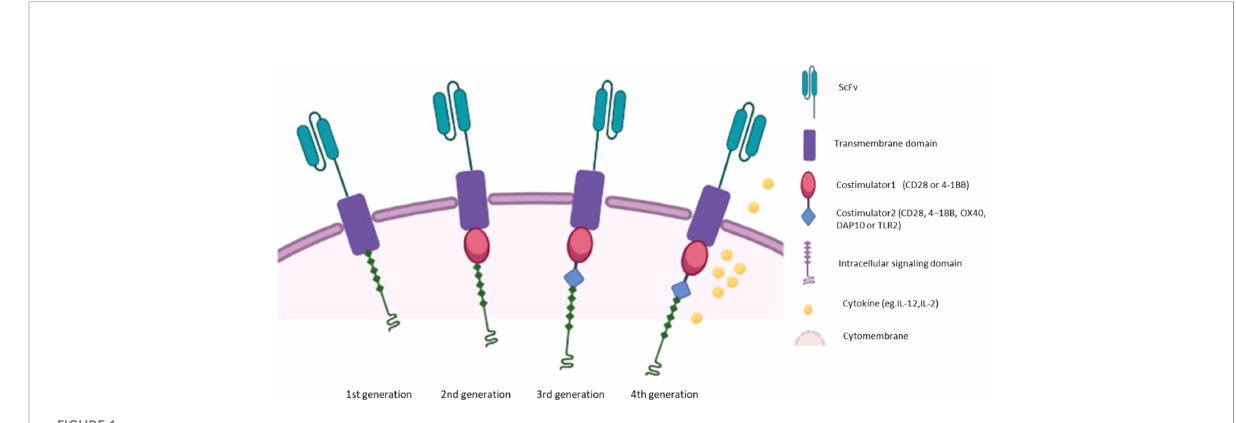
FIGURE 1 The chimeric antigen receptor (CAR) structure of four